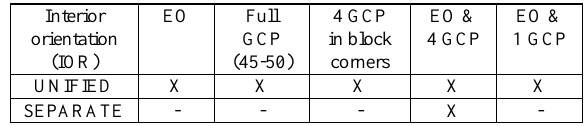
Table 2. Datum configurations with different EO and GCP